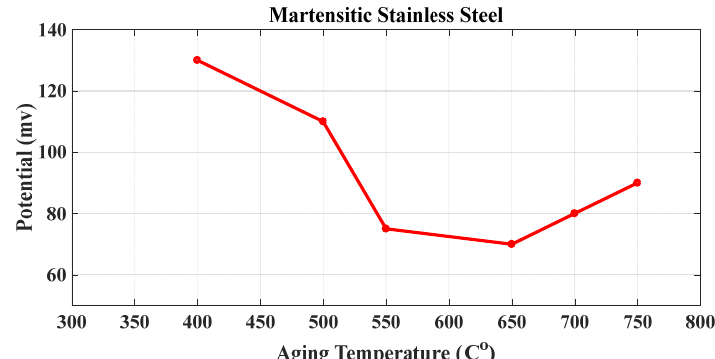
Fig. 14. Effect of aging temperature for 5 hours on voltage